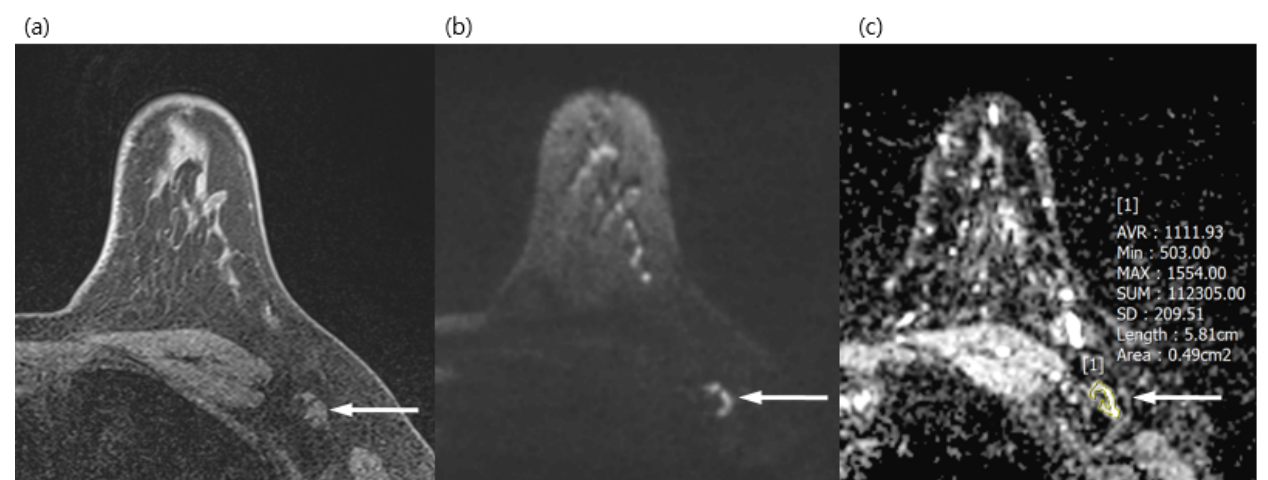
Figure 2. A 34-year-old woman with a surgically verified benign lymph node in left axilla level I. ( a ) Axial pre-contrast T1WI of left axilla shows a 1.2 cm lymph node with eccentric cortical thickening (arrow). ( b ) Axial DWI (b values, 1000 mm 2 /s) shows a lymph node (arrow) as a mixed area of high and low signal intensity. ( c ) Axial ADC map (b values, 1000 mm 2 /s) shows the same lesion with unrestricted diffusion (arrow). The region of interest was manually drawn on the ADC map, avoiding the fatty hilum and guided by a pre-contrast T1WI. The mean ADC of the lesion was 1.111 × 10 − 3 , which indicated a benign lymph node.